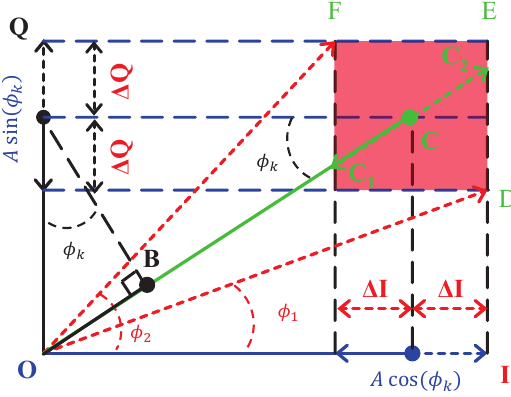
Figure 1. Principle of the determination of R . Abscissae represents the in phase component I = A cos ( φ k ) + η I , and ordinate represents the quadrature component Q = A sin ( φ k ) + η Q , where η I (cid:112) I 2 + Q 2 is an observation of A in and η Q are Gaussian noise terms. R = OC =